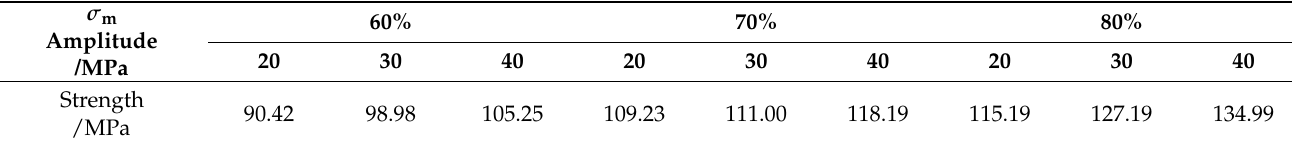
Table 3. Strengths of granite specimens under different conditions.